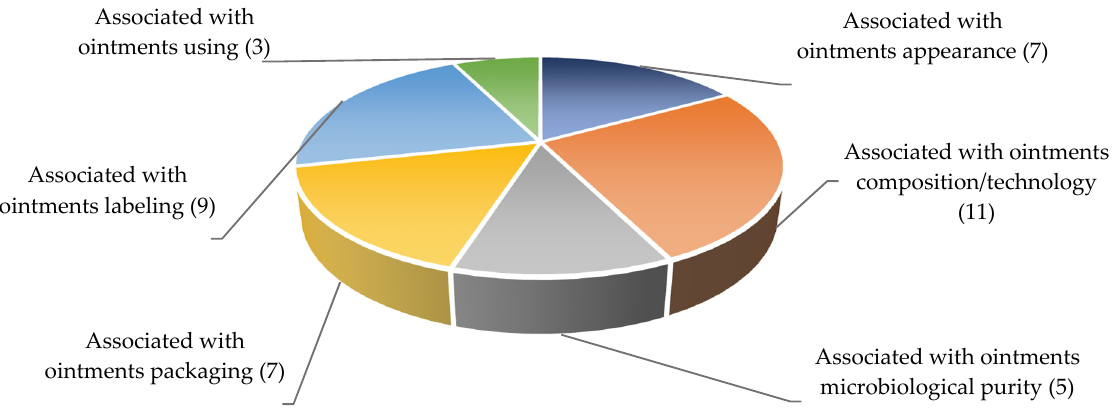
Figure 3. Possible deviations in compounded ointments quality.